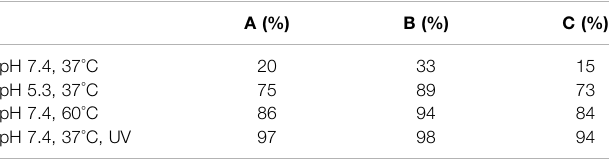
TABLE 1 | DOX release measured after 48 h from the three micellar polymer assemblies; A) SP-PDMAEMA, B) SP-(PMMA- b -PDMAEMA) and C) SP- (PDMAEMA- b -PMMA) (Razavi et al.,